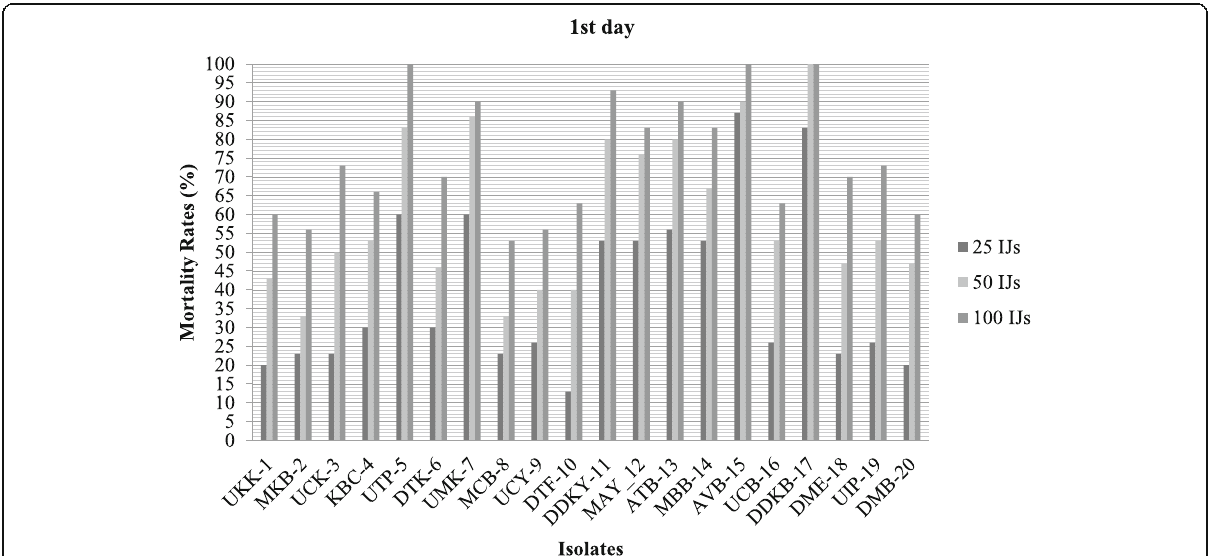
Fig. 1 The mortality rate (%) of entomopathogenic nematode isolates on Galleria mellonella larvae on the first day after treatment at 25 °C (25, 50, and 100 IJs). UKK-1, MKB-2, UCK-3, KBC-4, UTP-5, DTK-6, MCB-8, UCY-9, DTF-10, DDKY-11, MAY-12, ATB-13, UCB-16, DDKB-17, DME-18, UIP-19, and DMB-20: Steinernema feltiae isolate, UMK-7 and AVB-15: Heterorhabditis bacteriophora isolate, MBB-14: Steinernema